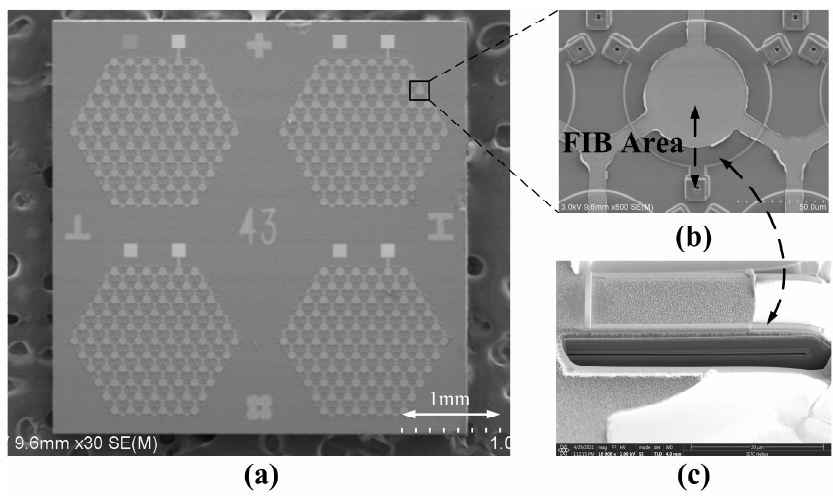
Figure 7. ( a ) SEM image of the fabricated PMUT chip with four arrays. ( b ) Enlarged view of a single PMUT unit. ( c ) Cross-sectional view of the PMUT structure via FIB cutting.